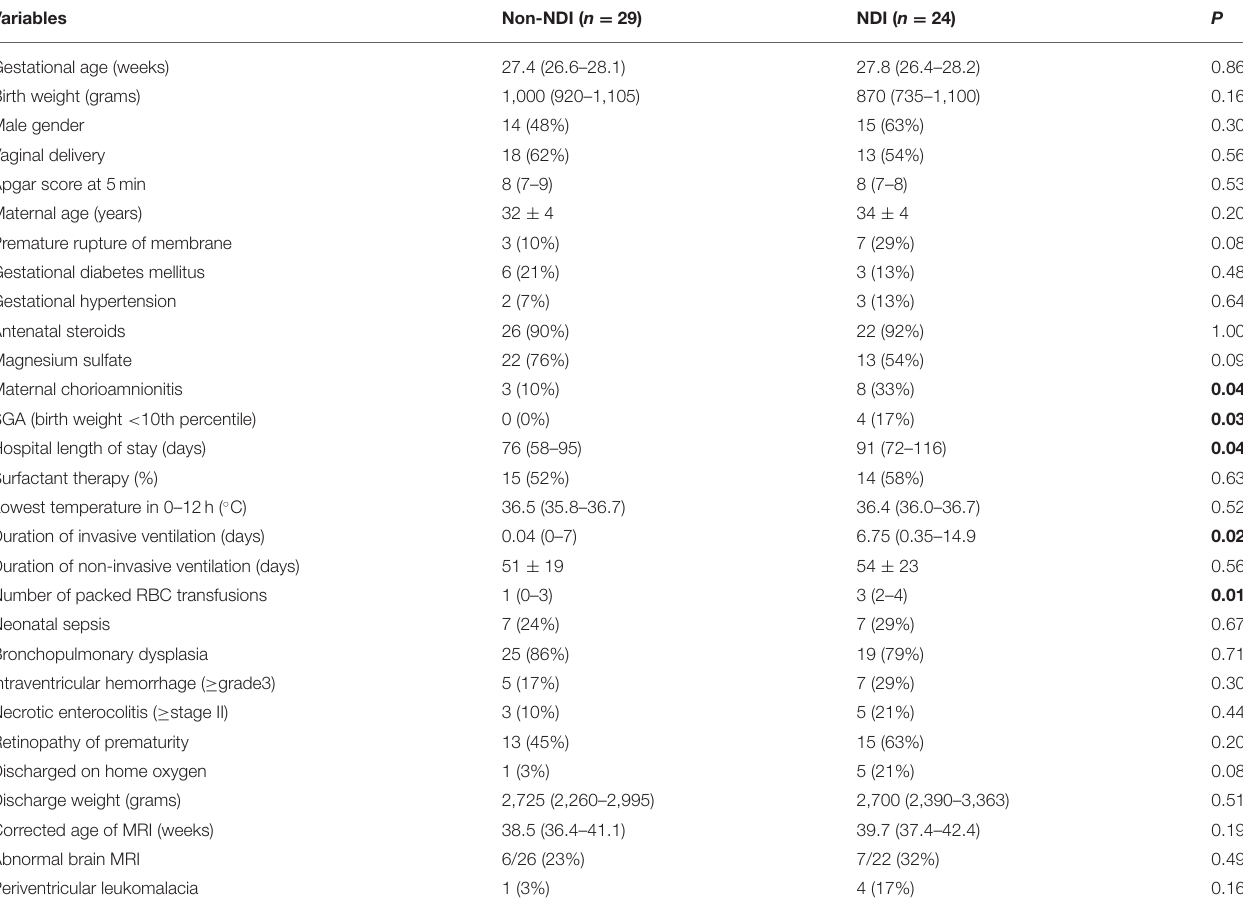
TABLE 1 | Socio-demographic and perinatal-neonatal characteristics between neurodevelopmental impairment (NDI) and non-NDI groups.